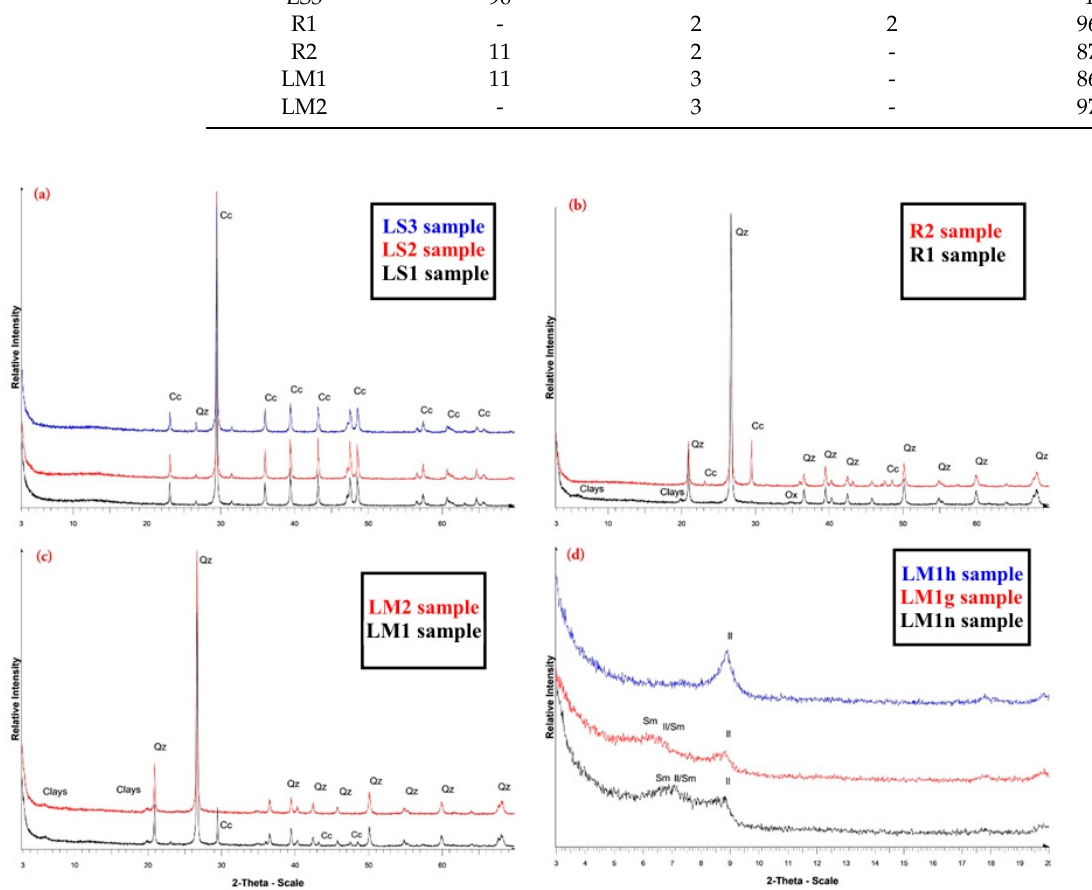
Figure 24. Representative X-ray powder diffractograms of bulk compositions ( a – c ) and clay fraction ( d ) analyses of studied samples. Abbreviations: Cc: calcite; Il: Illite; Sm: smectite, Il/Sm: mixed–layer illite/smectite; Ox: oxides; Qz: quartz; n: air-dried; g: glycolated; and h: heated. Note in Figure 24d of LM1 sample clay fraction analyses, the expected displacement of smectite and illite/smectite peaks, after expanding because ofethylene glycol treatment, as well as the disappearance of smectite and illite/smectite peaks after heating, due to their transformation to illite. Table 5. Mineral composition of studied rock materials. Abbreviations: Cc: calcite; Ox: oxides; Qz: quartz; and (-): not detected.